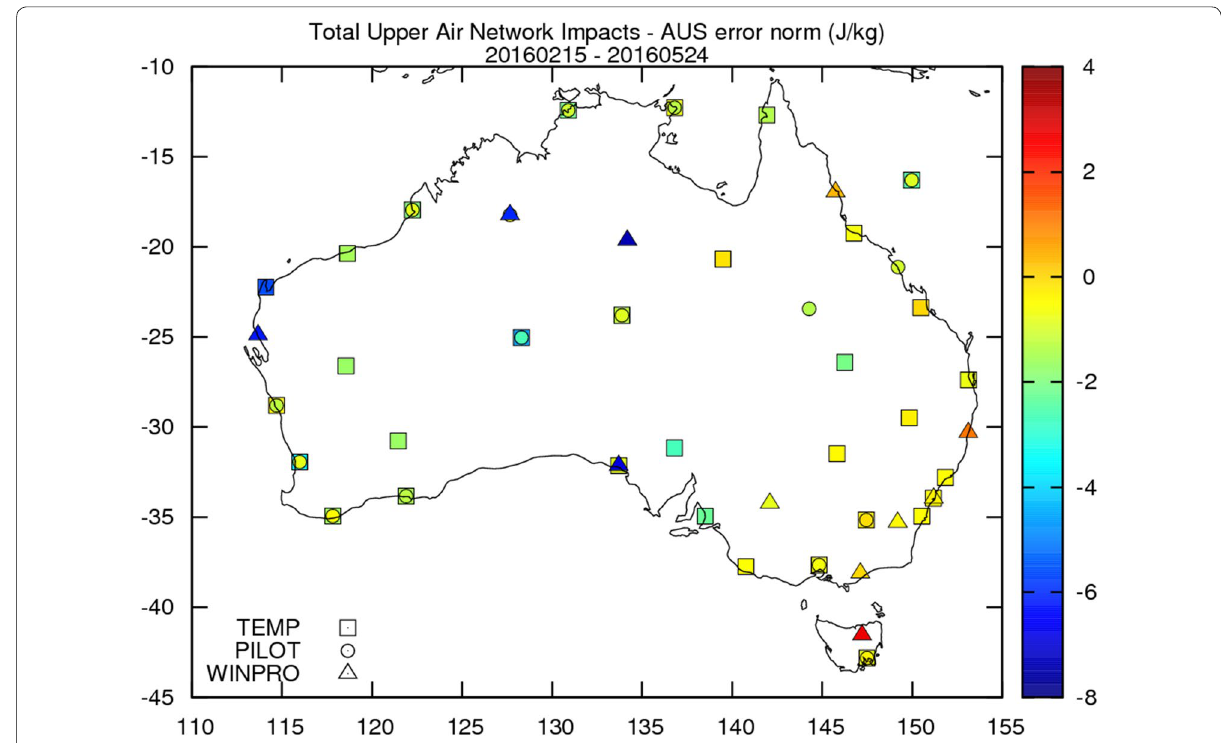
Fig. 7 Impacts of the Australian upper air network, using an error norm restricted to the Australian